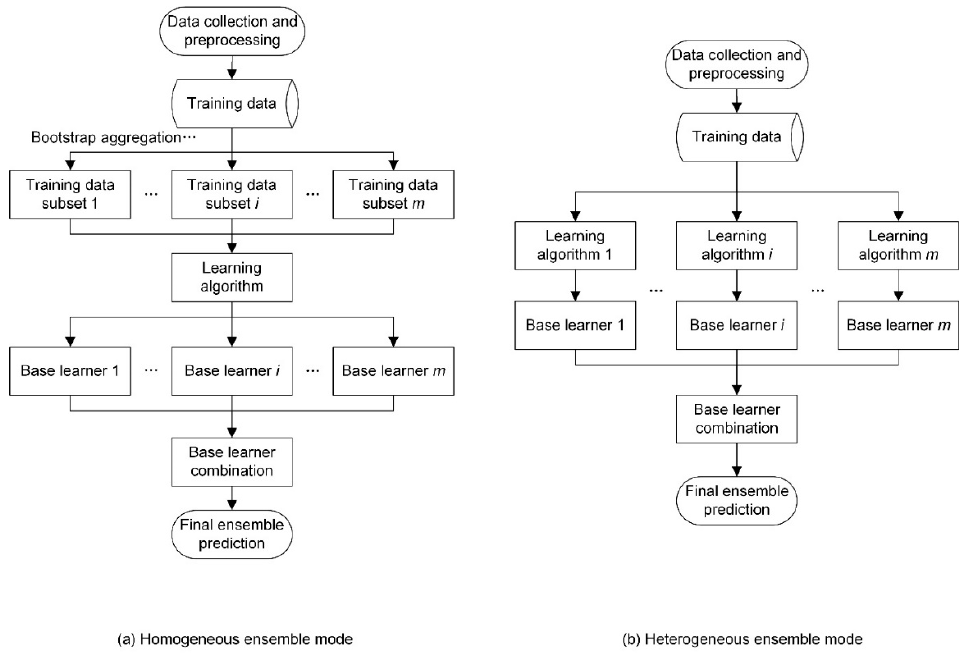
Figure 1. General framework for ensemble prediction models. ( a ) Homogeneous ensemble model and ( b ) heterogeneous ensemble model.